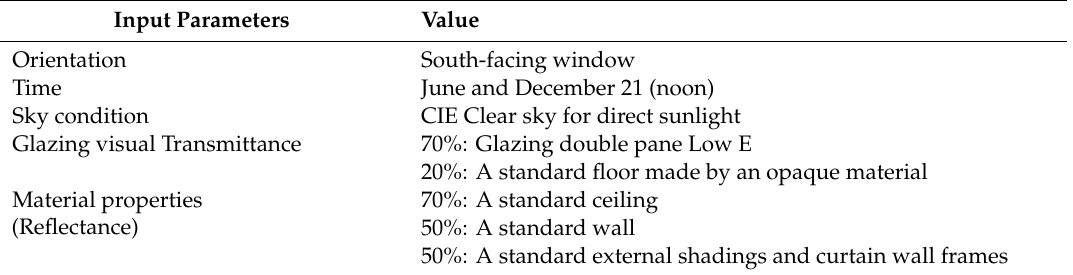
Table 3. Input parameters for the